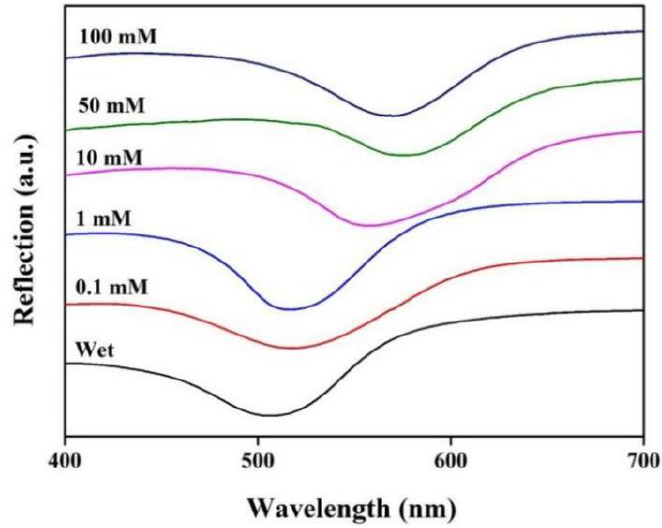
Figure 9. UV-visible reflection spectra of CLC-PAA urease photonic crystal hydrogel films after dropping urea solution (200 µL) with different concentrations for 10 min.